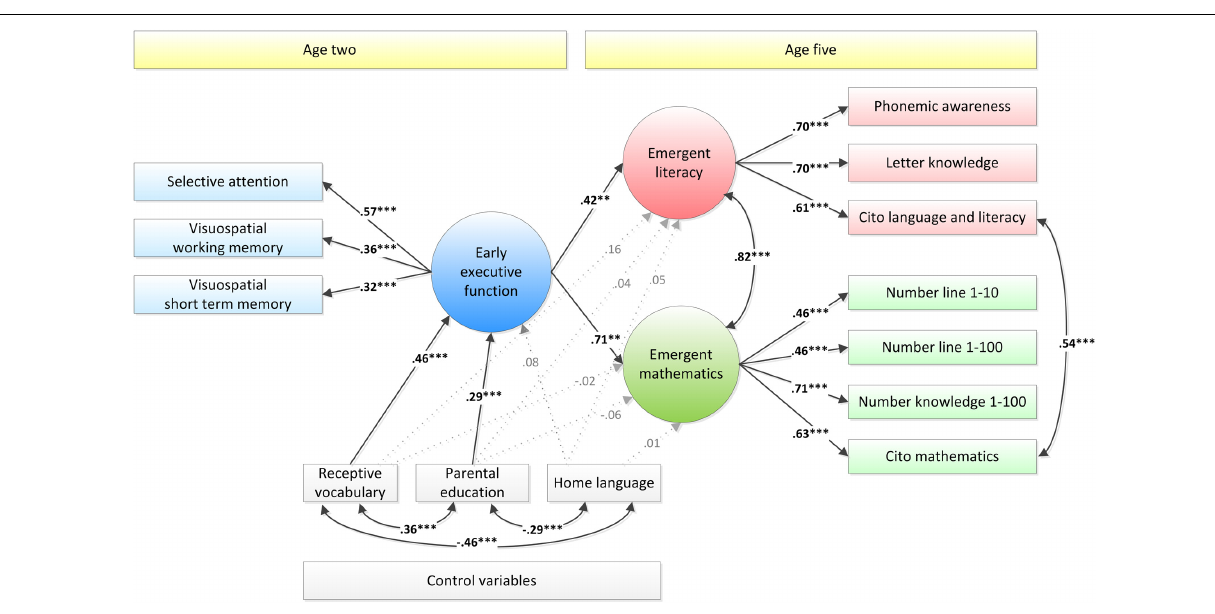
reading (for a review, see Swanson et al., 2009). Hence, it is